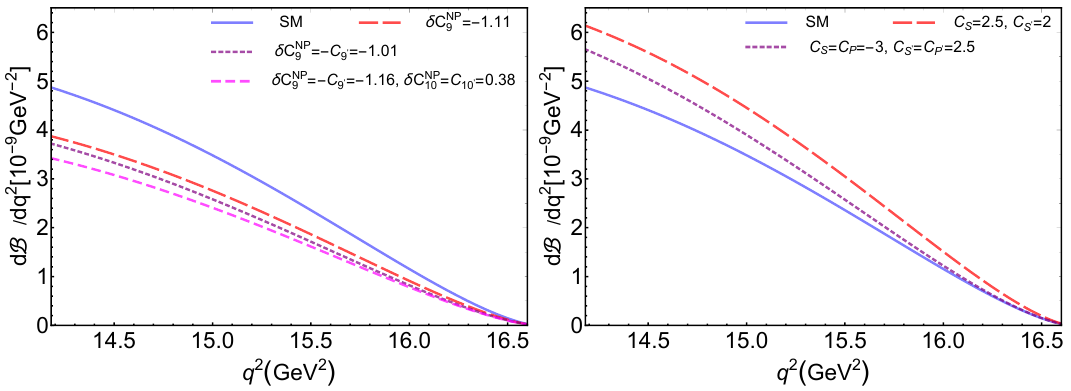
Figure 3 . The di(cid:11)erential branching ratio of (cid:3) b ! (cid:3) (cid:3) ( ! N (cid:22) K ) (cid:22) + (cid:22) (cid:0) is shown in the SM (blue solid line) and in the NP (dashed colored) at the low-recoil. The (cid:12)gures are for illustrative purpose only (see text for